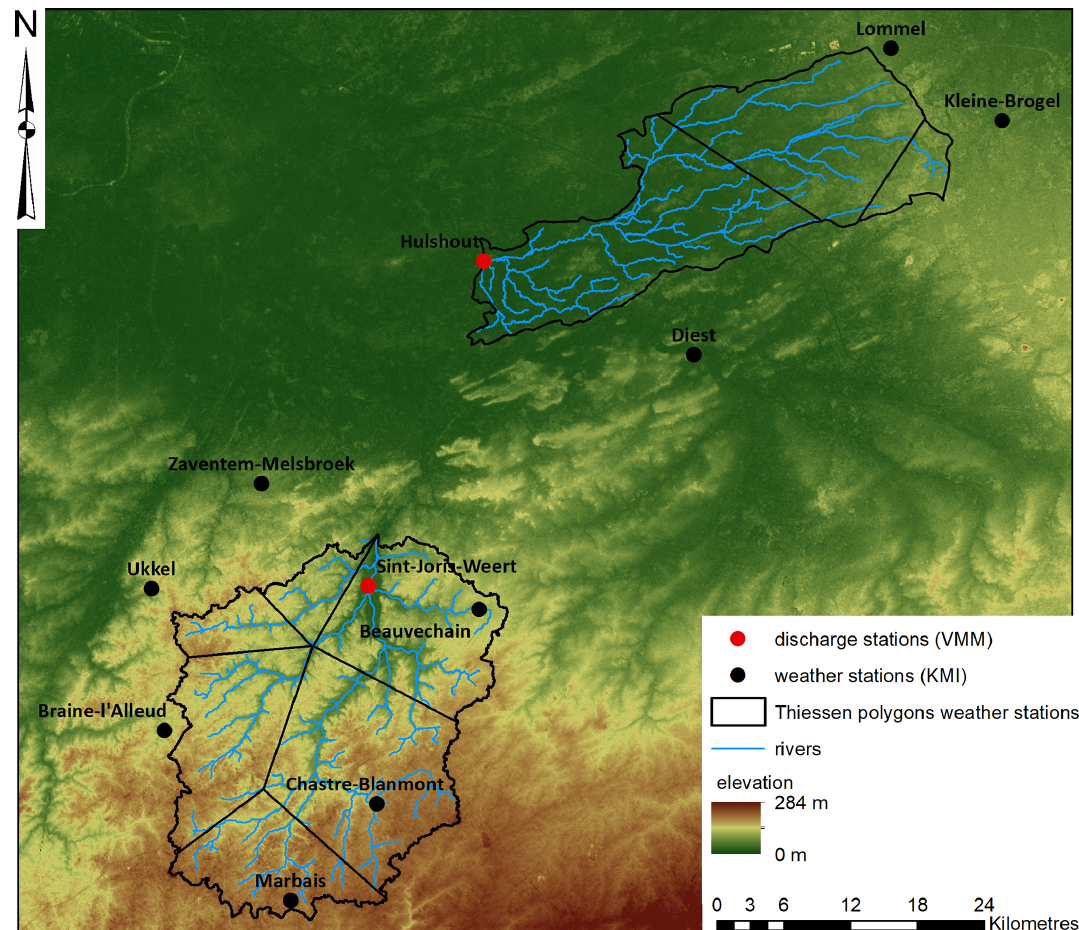
Figure A2. Map of the Dijle and Grote Nete basins, with indications of the discharge measuring stations (Flemish Environmental Agency, VMM) and weather stations (Belgian Royal Meteorological Institute, KMI) used for the calibration of STREAM. The river basins are subdivided by Thiessen polygons, based on the location of the weather